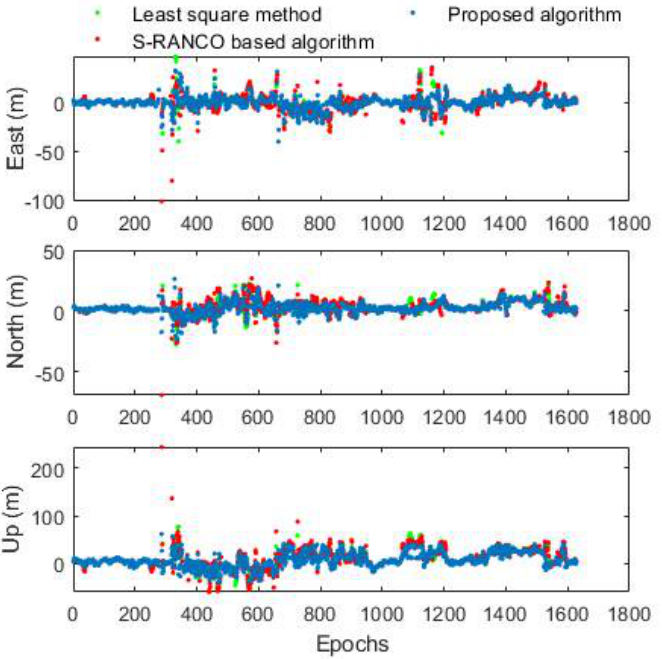
Figure 10. Positioning errors of the traditional method and the proposed FDE based method.